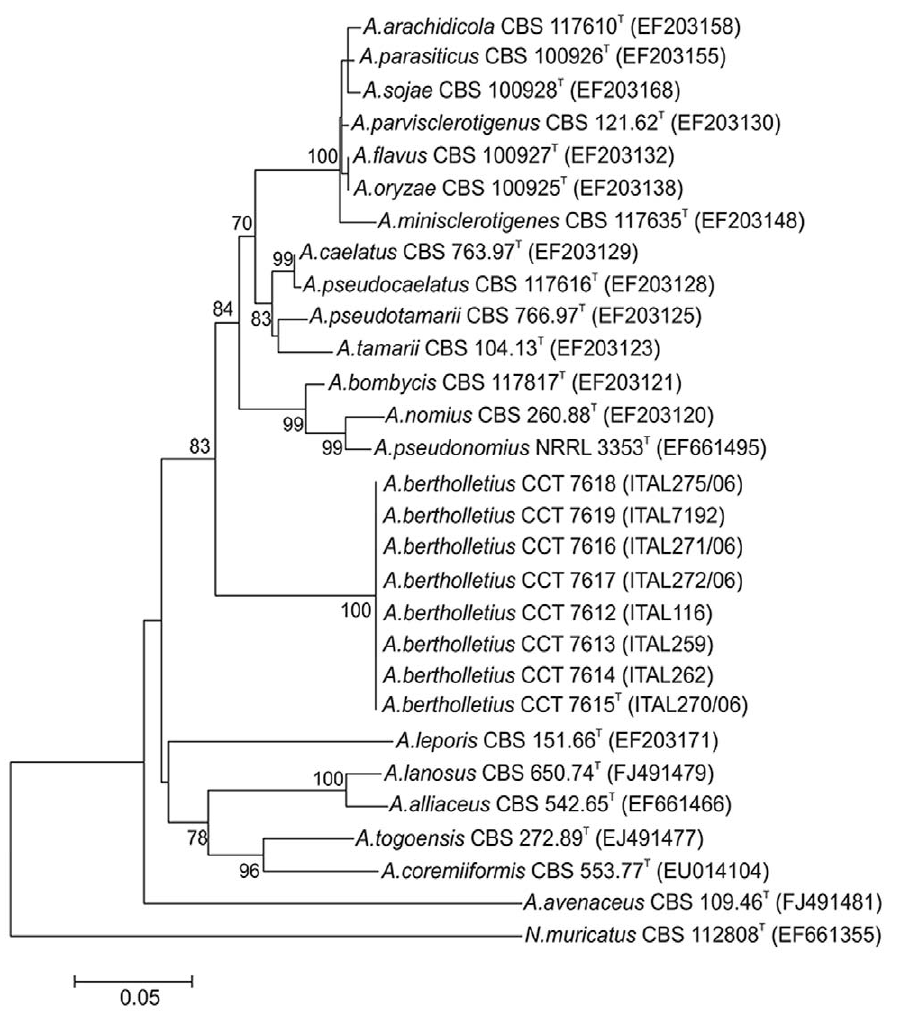
Figure 1. Neighbour joining tree reconstructed from the b -tubulin gene sequences aligned with corresponding sequences of Aspergillus section Flavi type species deposited in public databases. Numbers at branch nodes refer to bootstrap values (1000 replicates), only values of . 70% are shown. The nucleotide sequence from the type strain of A. bertholletius CCT 7615 (=ITAL 270/06) has been deposited in the GenBank databases under GenBank accession no. JQ744022.